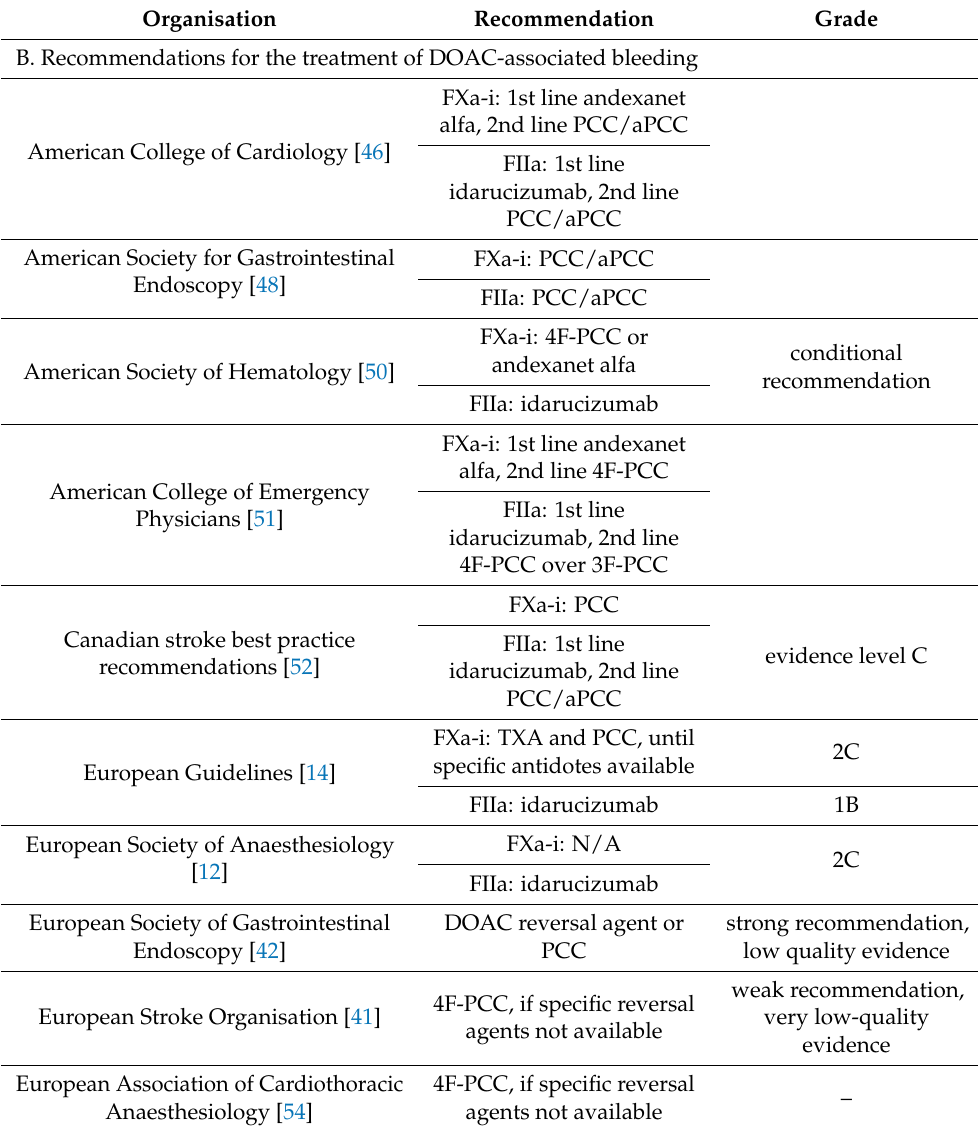
Table 1. Cont . Organisation Recommendation B. Recommendations for the treatment of DOAC-associated